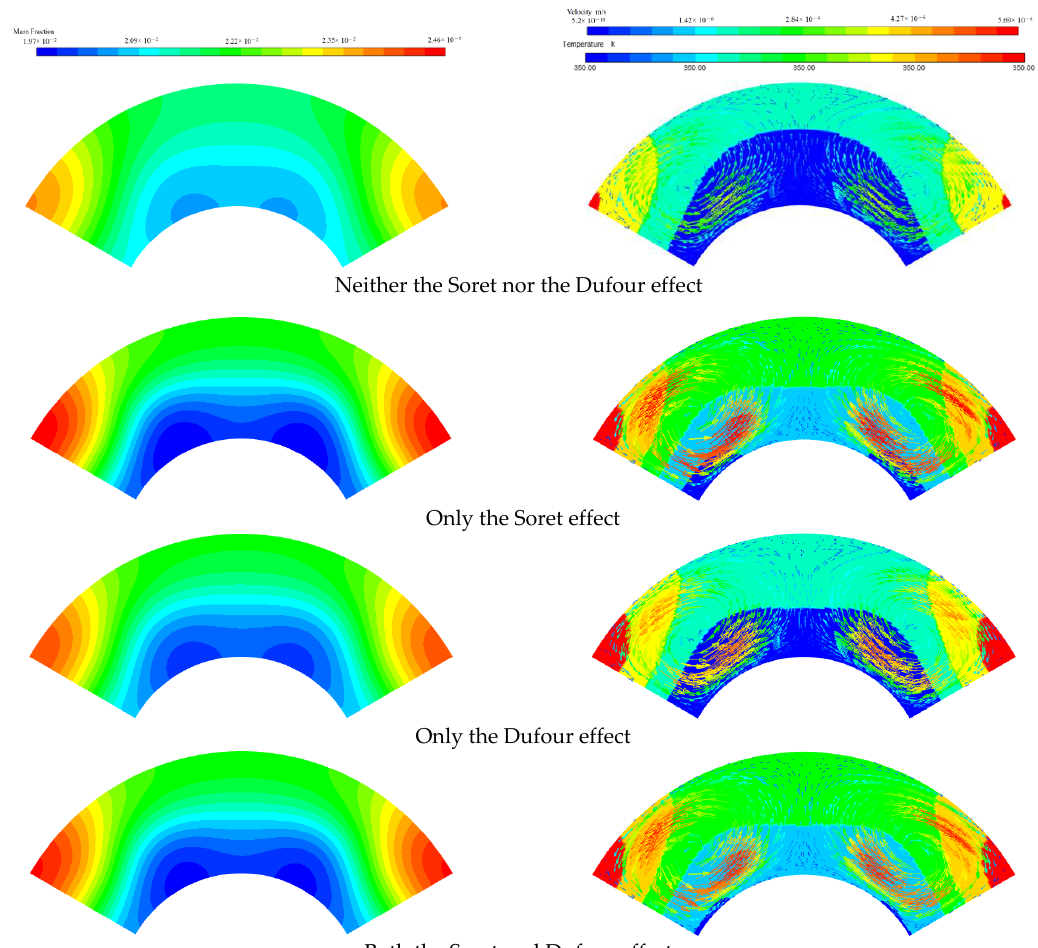
Figure 5. Comparisons of concentrations (left column) and velocities with temperatures (right column) at t = 3 s for various cases, neither Soret effect nor Dufour effect, only the Soret effect, only the Dufour effect, both Soret and Dufour effects being in consideration. The temperature of heat sources is 350 K, the initial mass fraction of nanoparticle is 5 wt%. The temperature gradient gradually decreases and goes to zero with time. At t = 10 s, the order of the concentration gradient is the case for neither the Soret nor the Dufour effect < only the Dufour effect < only the Soret effect < both the Soret and Dufour effects. Hence, for both the considered Soret and Dufour effects, the velocity in the flow domain is highest. However, the velocity of the flow domain is only slightly smaller for the sole Soret effect than for both the Soret and Dufour effects considered. That is, the effect on the flow, which is affected by both the Soret and Dufour effects, is not a simple superposition of the Soret and Dufour effects. The influences of the various cases on mass transfer are consistent at the initial stage. However, when the temperature and concentration gradi- ents are small, the mutual influence of concentration and temperature on the velocity is somewhat larger. This is because the nanoparticle migrates more rapidly to the location of reference point 1, and the concentration at reference point 1 is accordingly enhanced. In order to see the heat transfer in such a geometry, the heat transfer coefficients for various cases and at various times were calculated and listed in Table 3. Similar results as that for mass transfer can be drawn. The heat transfer coefficients for various cases are sorted as: neither the Soret effect nor the Dufour effect < only the Dufour effect < only the Soret effect < both the Soret and Dufour effects are considered. The mechanism is induced for convection, in the same way as for mass transfer. Table 3. The heat transfer coefficients for various cases and at various times (W/m 2 K). Cases